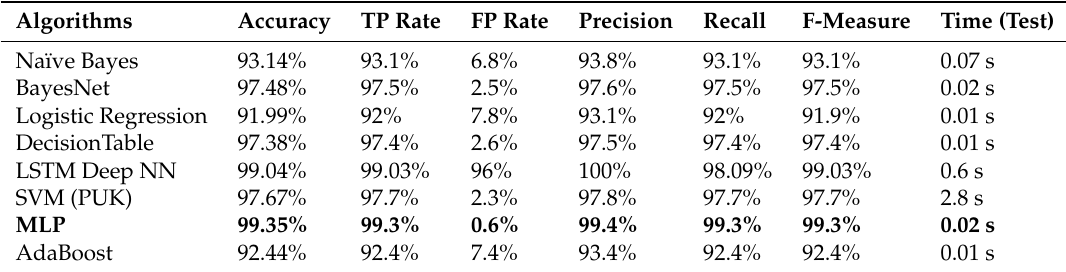
Table 11. Performance evaluation for attack scenario